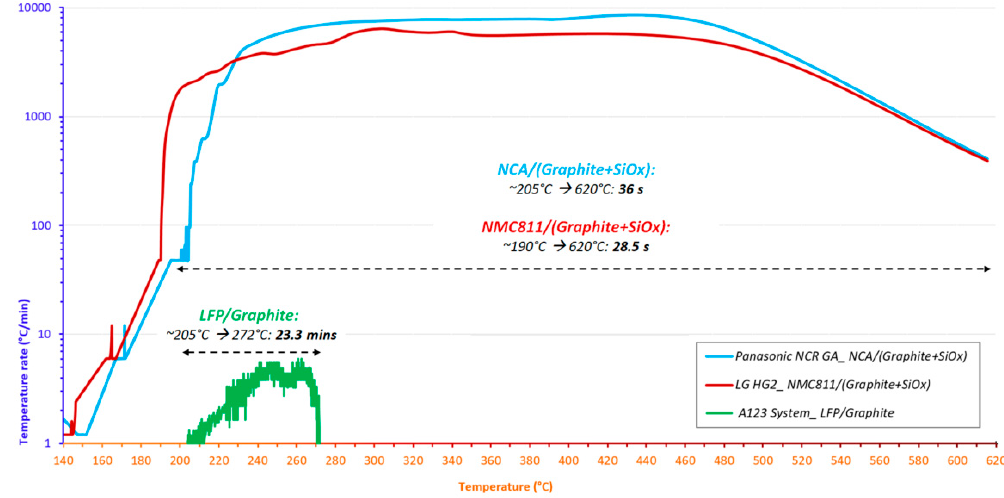
Figure 10. Comparison of the final stages of the thermal runaway of the selected Ni-rich technologies versus the “safest technology”, LiFePO 4 (LFP) /graphite.